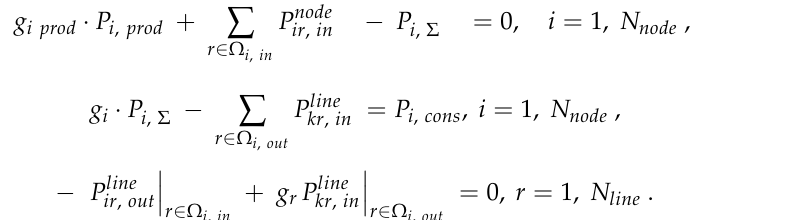
Equations (1) – (3) represent a generalized material balance.